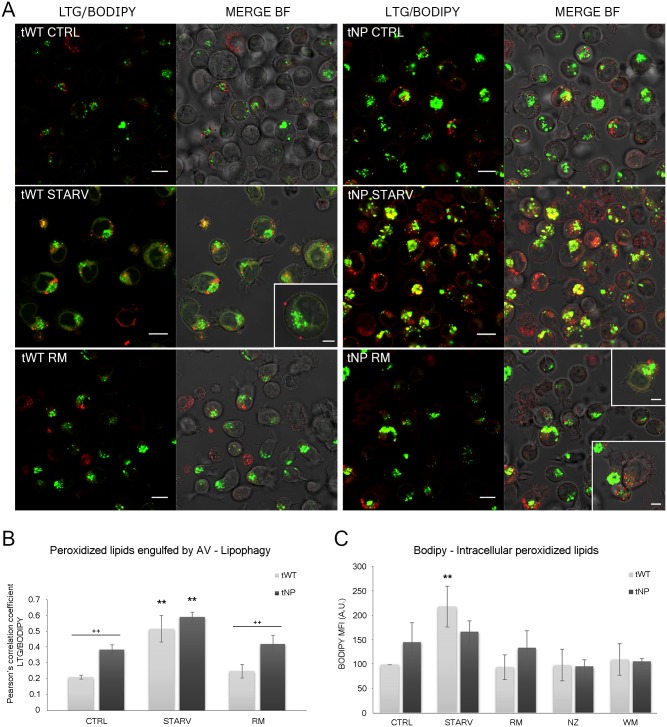
Evaluation of intracellular lipid content and lipophagy by BODIPY® 665/676 (BP).(A) Single confocal optical sections (~0.8 μm thickness) showing overlay of LTG (green) and BP (red) and the relative merge with bright field (BF), from control, nutrient deprivation and rapamycin- treated tWT and tNP cells. Insets show lipid droplets bound to the outer cell surface, probably newly extruded from the cell, or just below the outer cell membrane, most likely about to be exocytosed by the cell. Bars: 10 μm; 5 μm for insets. (B) Pearson's colocalization coefficient (PCC) for LTG and BP in control and pathologic cells for control, nutrient deprivation and rapamycin administration. Pearson's coefficients were derived from three completely independent experiments with >10 fields per experiment contributing to the cumulative result. Each value is expressed as PCC ± SD; **P < 0.01 vs respective control. The difference between cell lines was determined to be significant by two-way ANOVA (***P < 0.001). Two-way ANOVA with Bonferroni post test revealed a P value < 0.01 (++P < 0.01) between tWT and tNP basal condition and rapamycin-treated cells. (C) Statistical histogram of MFI variation of intracellular BP in tWT and tNP cells for each experimental condition. Mean values were converted to arbitrary units (A.U.) setting control of wild-type cells as 100. Each value is expressed as a relative mean ± SD (Results from n ≥ 3 independent experiments); **P < 0.01 vs respective control.